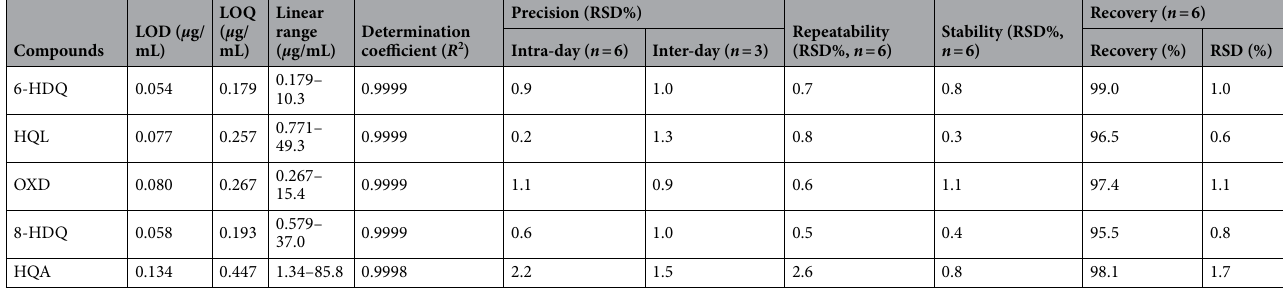
Table 2. The validation results of the UPLC method including LOD, LOQ, linear range, precision, repeatability, stability, and